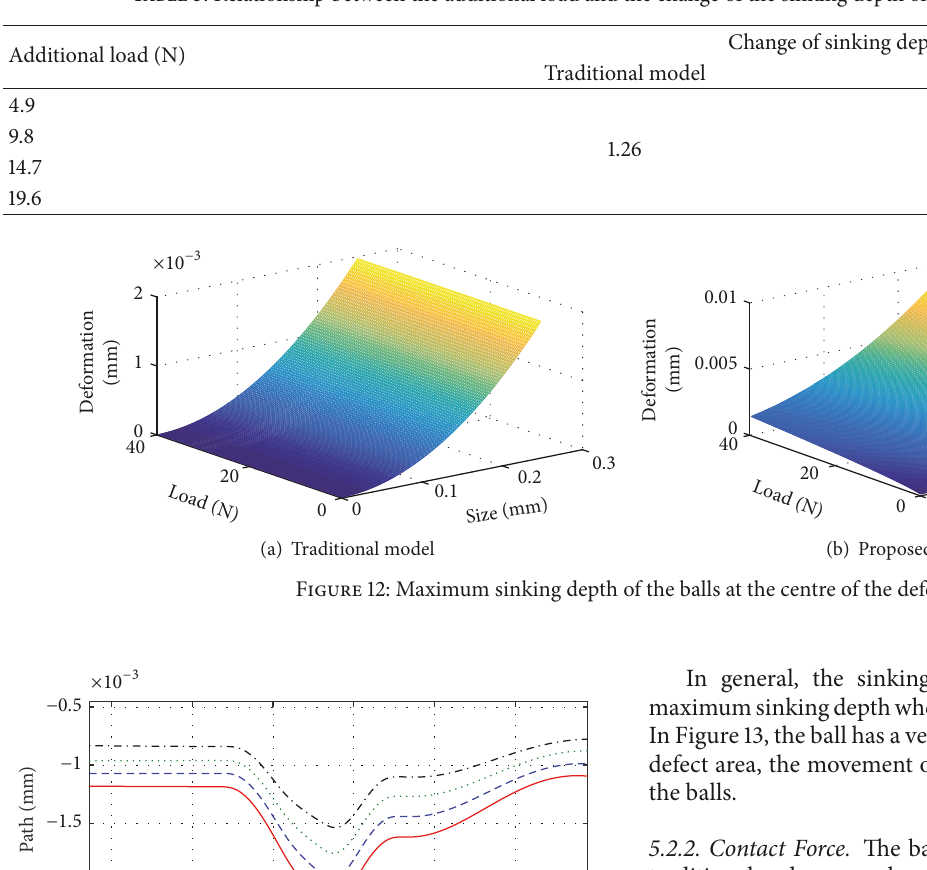
Table 3: Relationship between the additional load and the change of the sinking depth of the balls in Figure 13.